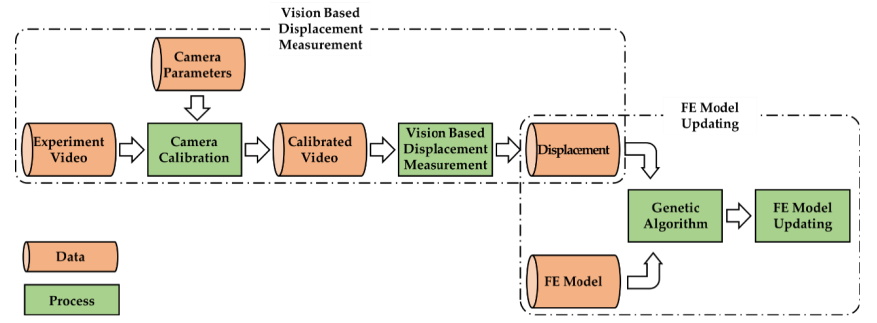
Figure 1. Overview of the vision-based finite element (FE) model updating .